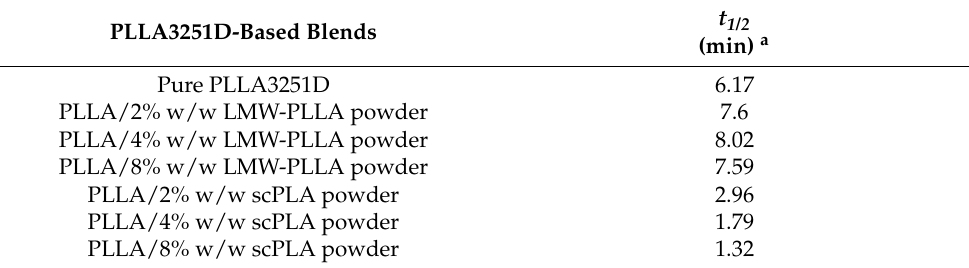
Figure 8. Relative crystallinity as a function of time of ( a ) PLLA3251D/LMW-PLLA powder and ( b ) PLLA3251D/scPLA powder blends. Table 5. Half-crystallization times ( t 1/2 ) of PLLA3251D/LMW-PLLA powder and PLLA3251D/scPLA powder blends from relative crystallinity as a function of time in Figure 8.